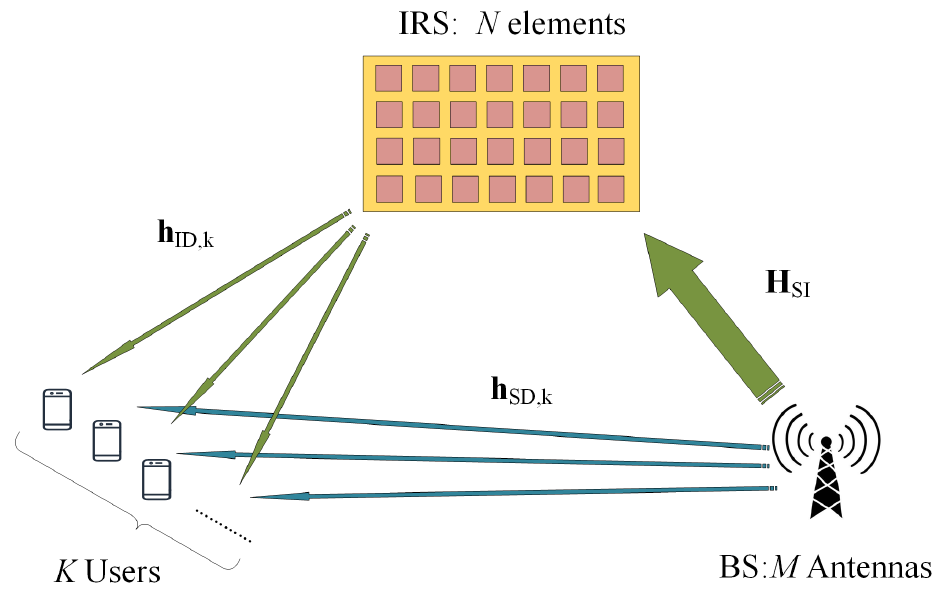
Figure 1. System